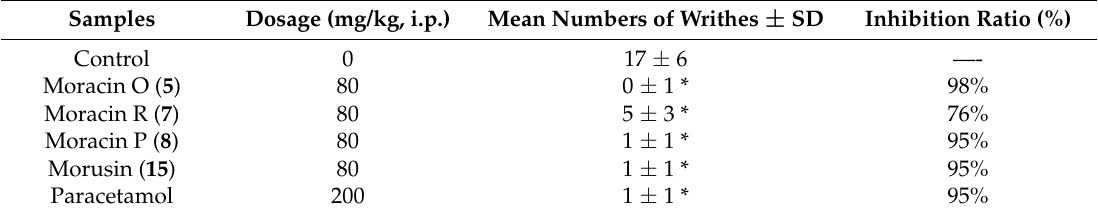
Table 4. Analgesic effects of neuroprotective stilbenes on acetic acid-induced pain. Samples Dosage (mg/kg,